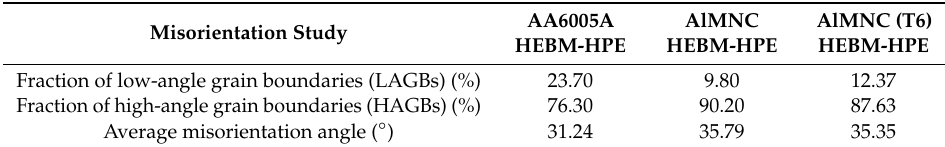
Figure 8. ( a ) EBSD Crystal Orientation Map (COM) with inverse pole key for cubic materials inset in the bottom left corner, ( b ) grain size distribution histogram, and ( c ) misorientation angle distribution histogram obtained from cross-sections of the aluminium matrix of the extruded profile of AlMNC-HEBM in the aged condition. Di ff erent colours reflect the crystal lattice orientation positions in the Euler space. LAGBs and HAGBs are denoted by white and black lines, respectively. Table 3. Boundary misorientation distributions in extruded profiles of AA6005A-HEBM and AlMNC HEBM, before and after T6 heat treatment powders obtained from EBSD analysis. HPE: hot powder extrusion.